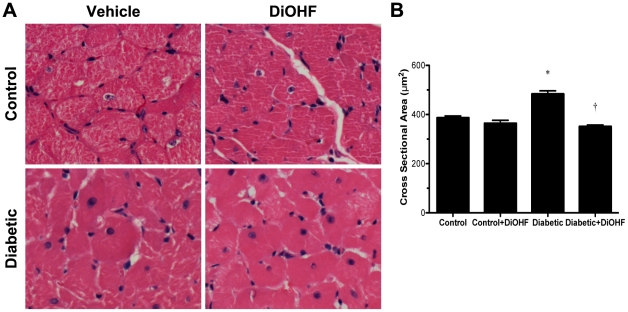
Representative images for myocyte hypertrophy.(A) Diabetic rats demonstrated myocyte hypertrophy as evidenced by increased cross sectional area when compared with control rats. Treatment with DiOHF reduced cross sectional area in diabetic rats but had no effect on control rats. (B) Quantitative data for myocyte cross sectional area. *P<0.05 vs control (non-diabetic) rats; †P<0.05 vs diabetic rats. Original magnification ×200.